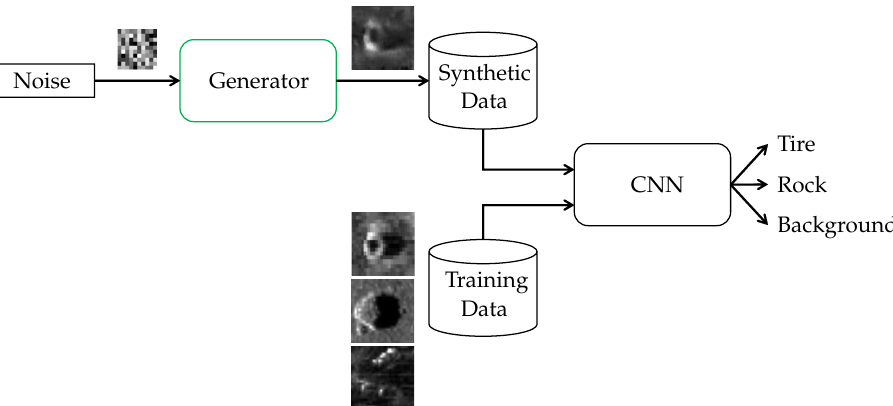
Figure 15. Augmentation of a CNN with samples generated by the trained